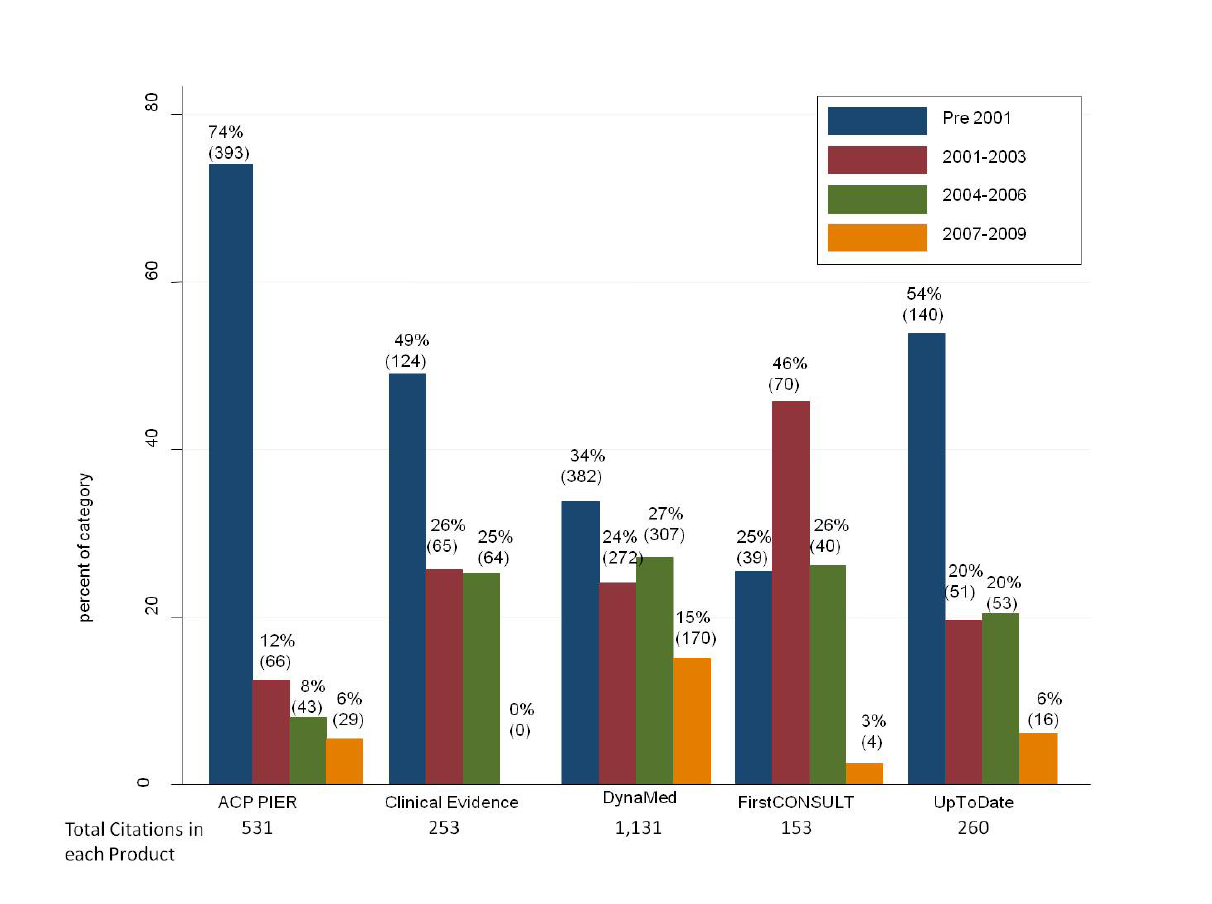
Figure 2. Currency of citations in point-of-care